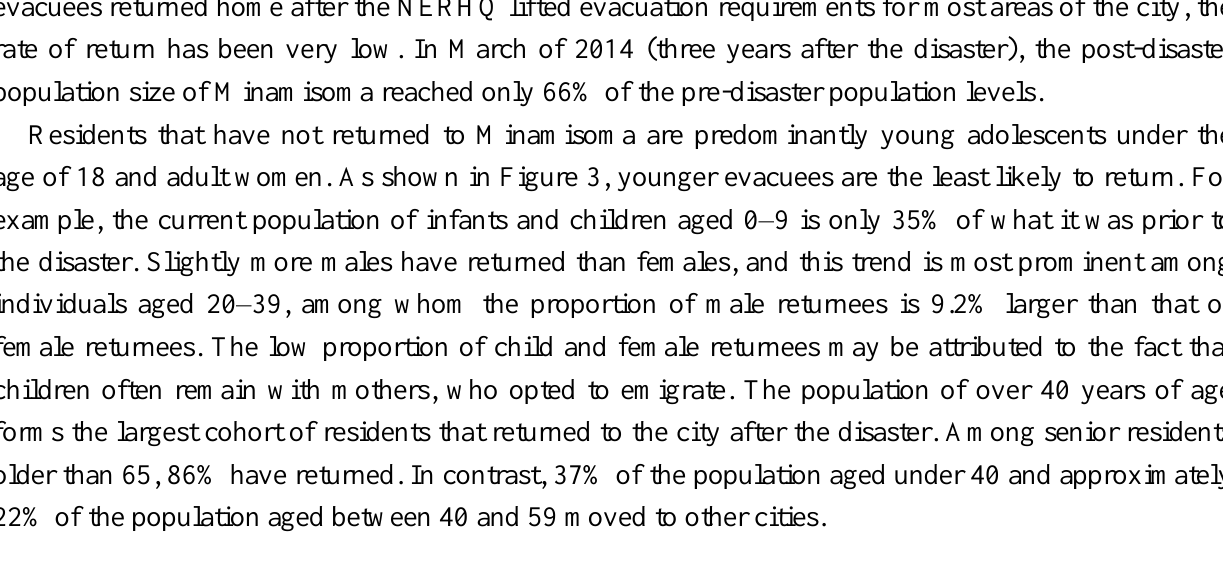
Figure 3. (A) Population Remaining in Minamisoma after the disaster by Gender and Age. (B) Percentage of Population Decrease by Age (comparison between 10th March 2014 and 11th March 2011) Data Source: Statistics Department of Information Policy, Division of General Affairs Office of